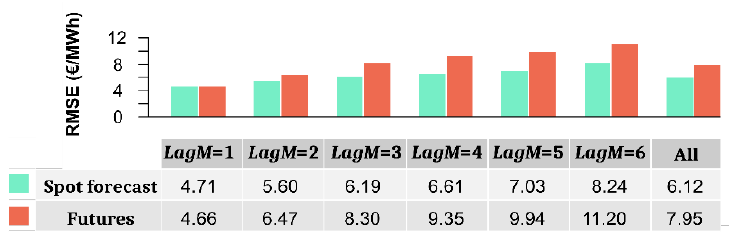
Figure 4. Root mean square error, RMSE, of the monthly average spot forecast price (Spot forecast) and the Futures prices (Futures) in relation to the ex post monthly average spot price.